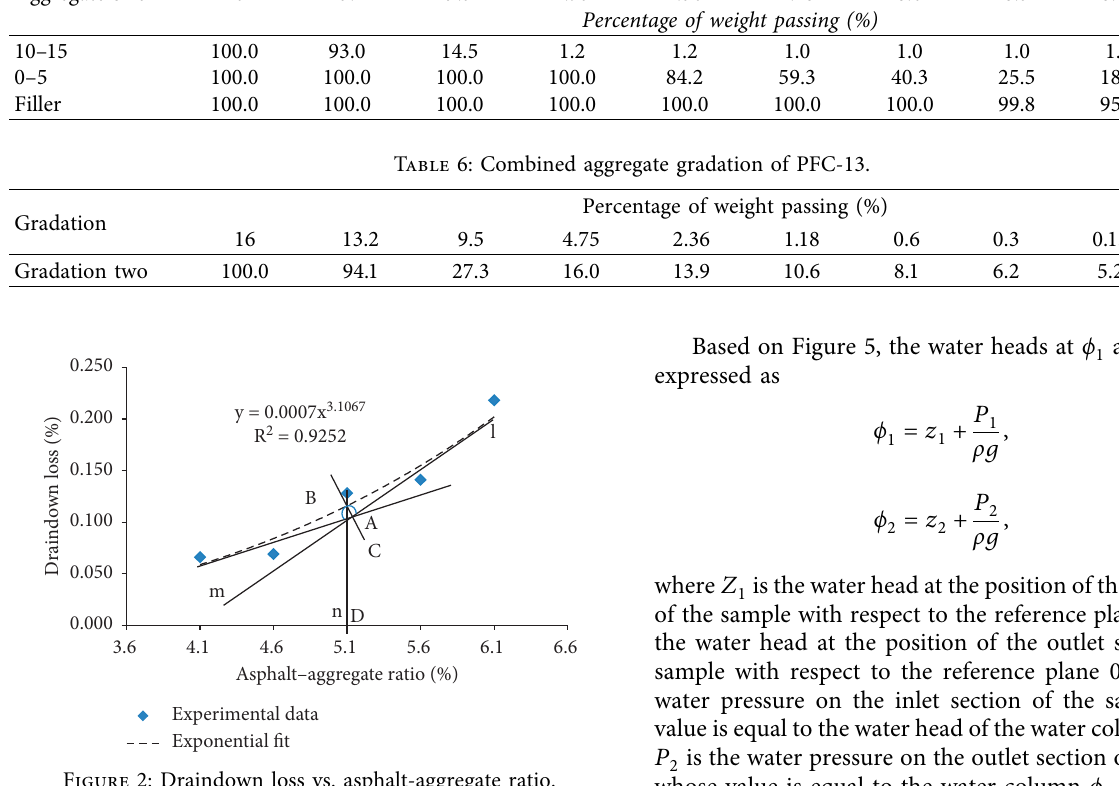
Figure 2: Draindown loss vs. asphalt-aggregate ratio.